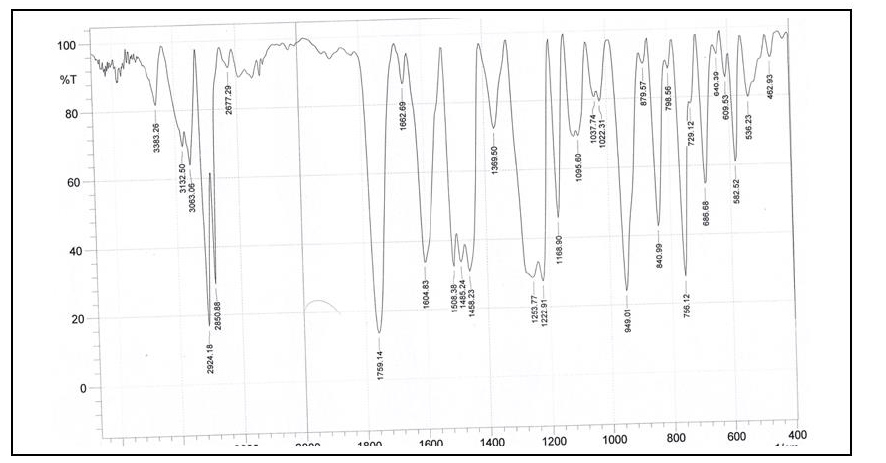
Fig. 7. FT-IR spectrum of PG